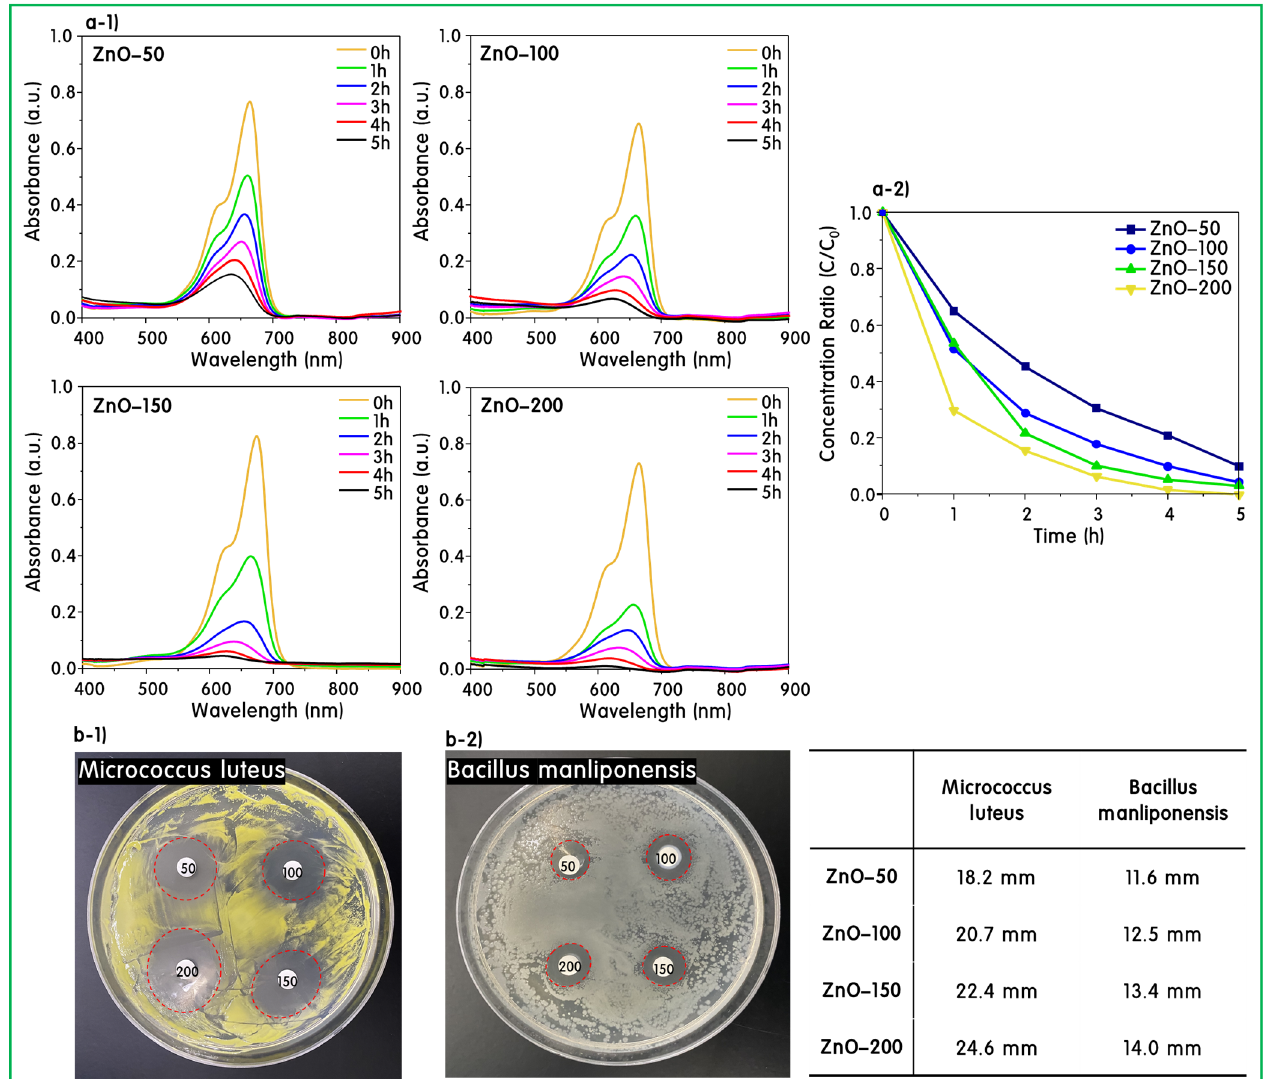
Figure 7. ( a1 – a2 ) MB dye decomposition performance ( b1 – b2 ) Antibacterial performance accord- Figure 7. ( a-1 , a-2 ) MB dye decomposition performance ( b-1 , b-2 ) Antibacterial performance according ing to the ZnO nanoplates each temperature synthesized. to the ZnO nanoplates each temperature Table 1. Comparative study of photocatalytic degradation of MB under visible light.